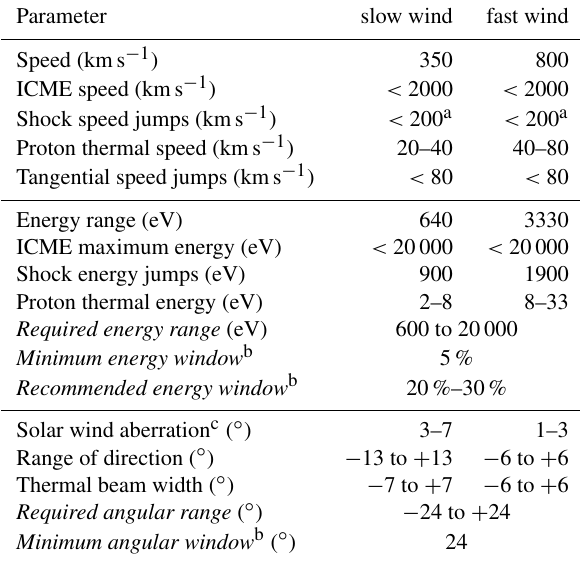
Table 1. Solar wind parameters at 1au (in roman type) and instru- ment requirements (in